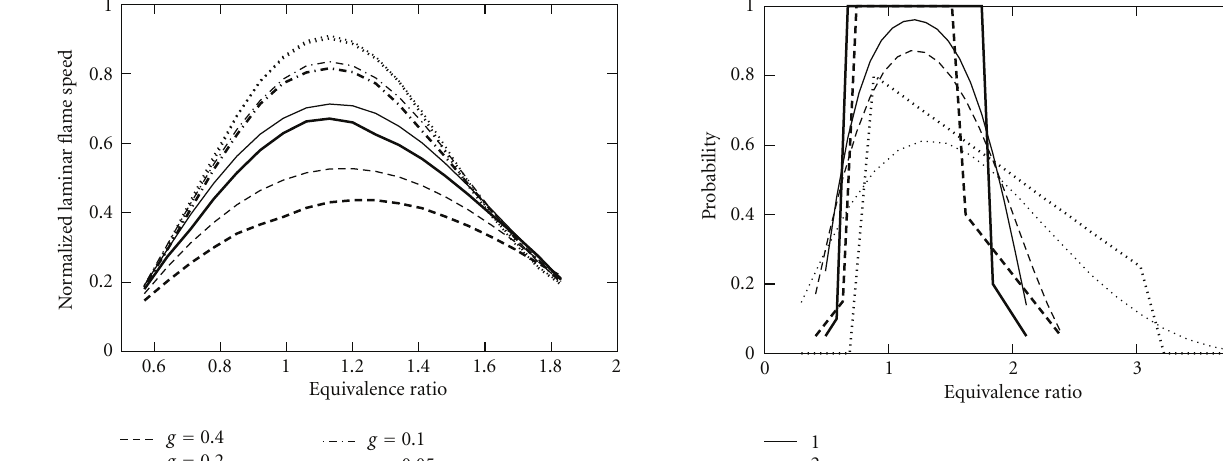
of the normalized L